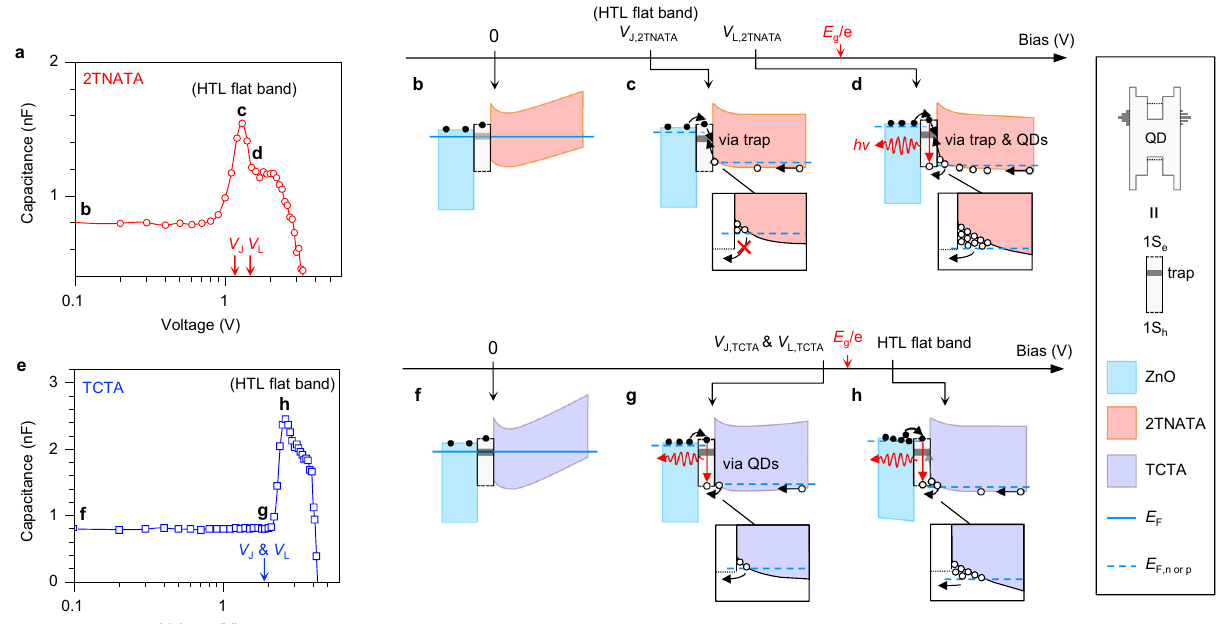
Fig. 3 Carrier accumulation and injection under modi fi ed energy band landscape. a Capacitance ( C ) – voltage ( V ) characteristic of 2TNATA-based QLEDs. Current ( V J ) and luminance thresholds ( V L ) are 1.2 eV and 1.5 eV, respectively (red arrows). b – d Band diagrams of ZnO/QD/2TNATA with increasing bias, from V = 0 V ( b ), to 1.2 V ( c ), and to 1.5 V ( d ). e A C – V characteristic of TCTA-based QLEDs. V J and V L are identical to 1.9 eV (blue arrow). f – h Band diagrams of ZnO/QD/TCTA with increasing bias, from V = 0 V ( f ), to 1.9 V ( g ), to 2.6 V ( h ). Legend for b – d and f – h is shown on the right panel. Blue lines represent the E F at equilibrium (solid line) and the quasi-Fermi level of electron ( E F,n ) and hole ( E F,p ) under applied bias (dashed line). We note that the quasi- E F of HTLs is de fi ned by molybdenum oxide/Al anode, assign at ~0.3 eV smaller than E HOMO, HTL